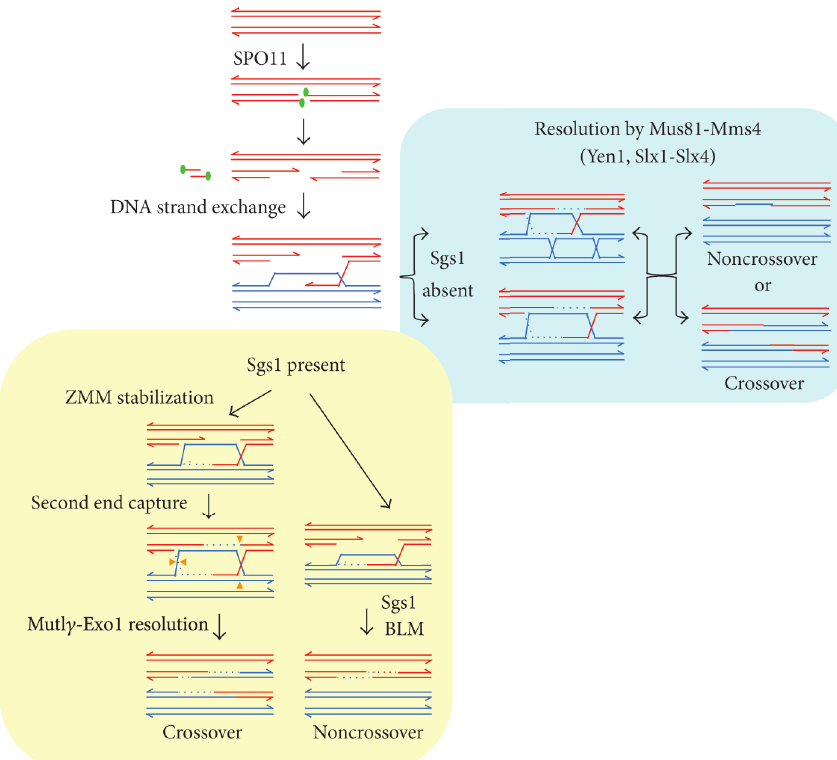
F 1: Homologous recombination during meiosis. Meiotic recombination begins with a break made by Spo11 in one of the two double- ends of this break are resected leaving tails of 3 single-strand DNA. When the 3 ssDNA strand DNA molecules of one chromosome. e 5 invade a homologous chromatid, the presence of the Sgs1 protein can reverse the strand inversion intermediates to form a noncrossover � � � outcome or promotes association of some legitimate strand invasion intermediates with the ZMM protein complex. ese molecules are resolved in a crossover, mainly by MutL -Exo1. Molecules formed in the absence of Sgs1 are the target of Mus81-Mms4, Yen1, and Slx1–Slx4, which resolve in a random mode to give both crossover and noncrossover outcomes. 𝛾𝛾